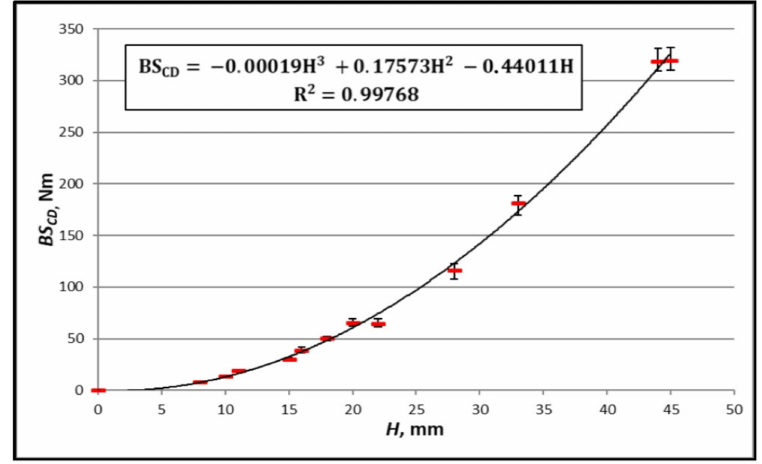
Figure 11. Measurements of BS CD boards TL135/TL135/TL135 with core cell size of D = 15 mm and different thicknesses.